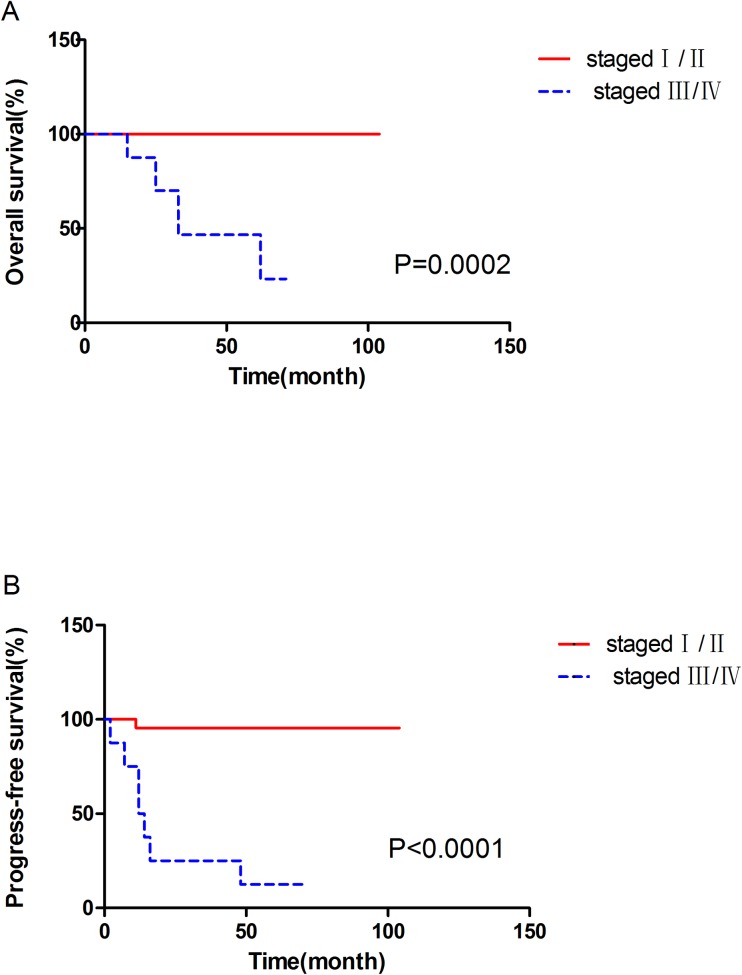
Survival curves of overall survival (A) and progression-free survival (B) between stage I/II and stage III/IV patients. The overall survival and progression-free survival between stage I/II and stage III/IV in Xp11.2 tRCC were statistically significant.